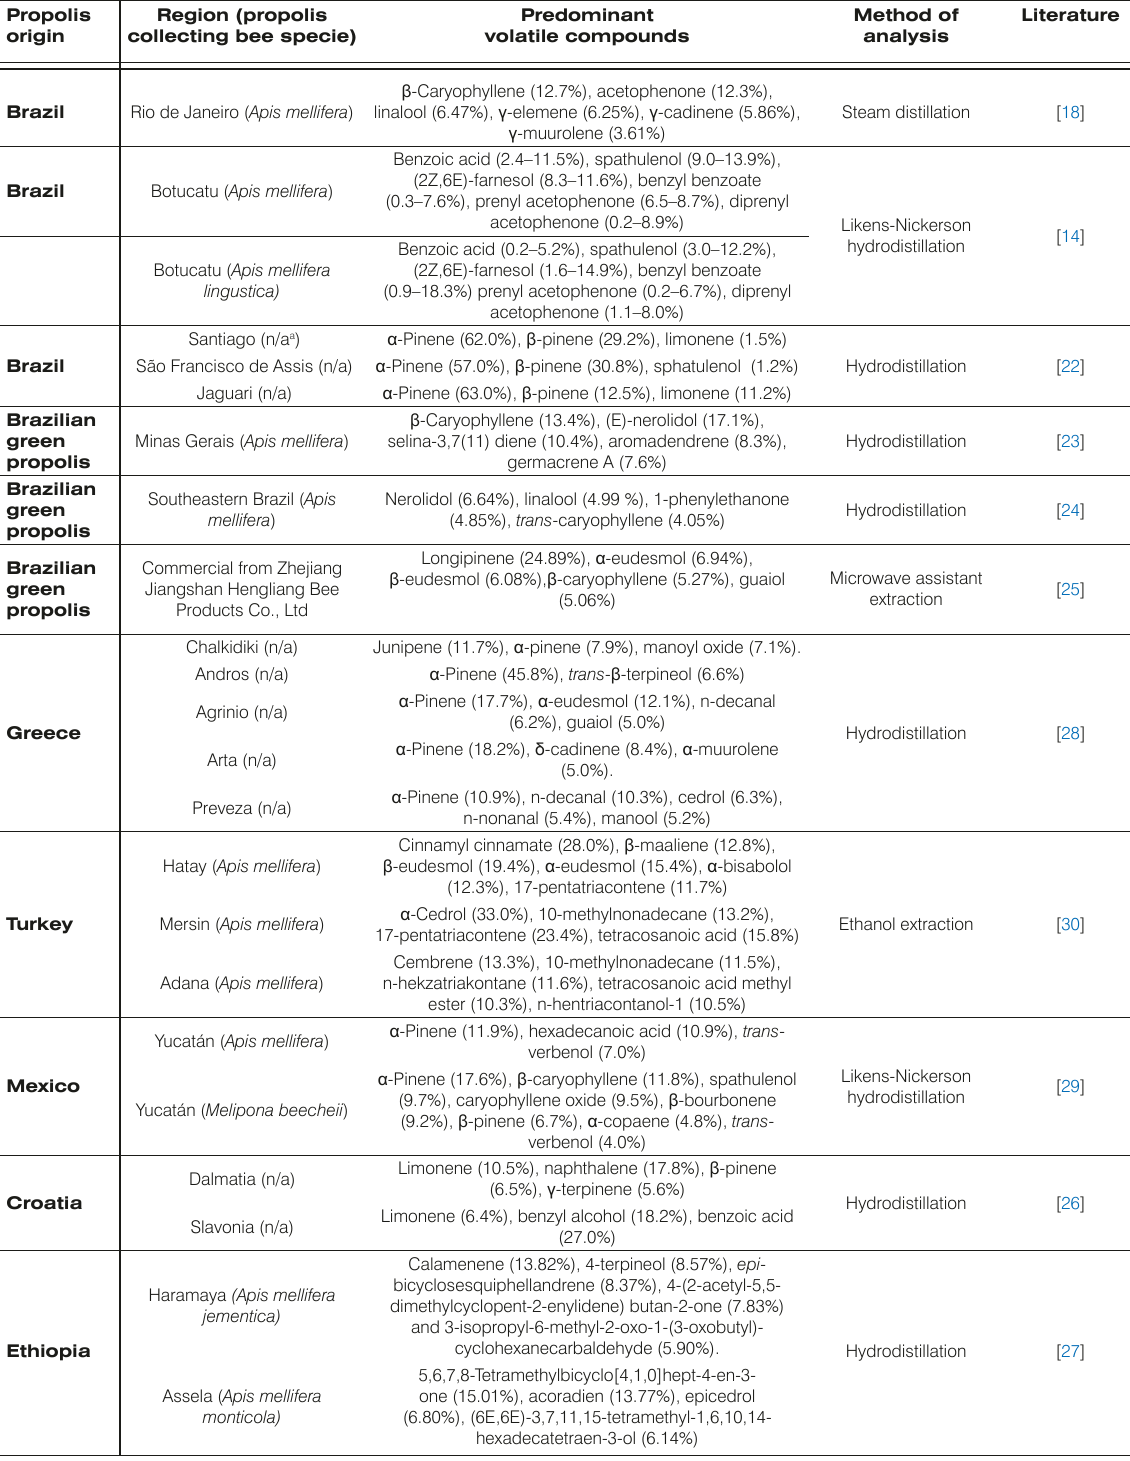
Table 1. The predominant volatile compounds identified in